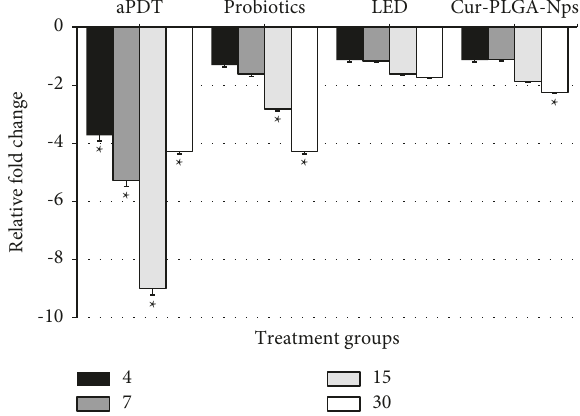
Figure 3: Changes in gene expression of gtfB following treatment with different groups at the different time intervals. The error bars represent the standard deviation. ∗ Significant differences according to the control group (day 0), P < 0 .